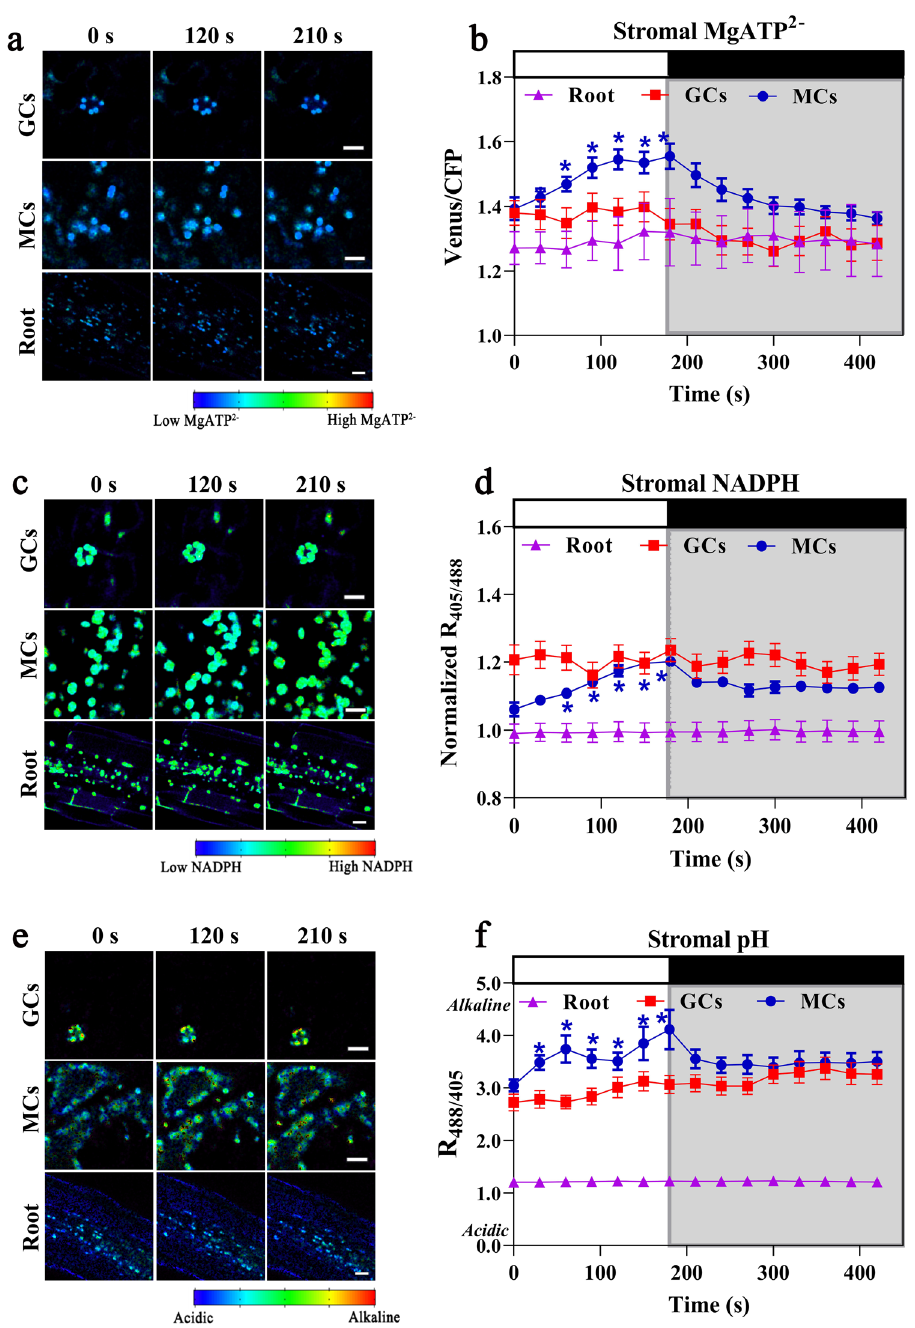
Fig. 2 Real-time light responses of stromal MgATP 2 – , NADPH and pH sensors in 21-day-old plants. The ratiometric shifts of a, b MgATP 2 – sensor AT1.03 ( p -values of panel b: 0 s vs. 60 s = 0.007, 0 s vs. 90 s = 0.001, 0 s vs. 120 s = 2.5 × 10 − 4 , 0 s vs. 150 s = 1.9 × 10 − 4 , and 0 s vs. 180 s = 4.3 × 10 − 4 ), c, d NADPH sensor iNAP4 ( p -values of panel d: 0 s vs. 60 s = 0.015, 0 s vs. 90 s = 0.001, 0 s vs. 120 s = 0.001, 0 s vs. 150 s = 0.001, and 0 s vs. 180 s = 0.006), e, f pH sensor cpYFP ( p -values of panel f: 0 s vs. 30 s = 0.012, 0 s vs. 60 s = 0.036, 0 s vs. 90 s = 0.021, 0 s vs. 120 s = 0.015, 0 s vs. 150 s = 0.041, and 0 s vs. 180 s = 0.032) in plastid stroma of mesophyll cells (MCs), guard cells (GCs) and roots in response to white light illumination at 216 μ mol m − 2 s − 1 (30-s intervals for 180 s) are presented. Asterisks indicate signi fi cant statistical differences (* P < 0.05) between the data points collected during illumination (30 – 180 s) and the data point collected before illumination (0 s), as determined by paired t -test, two-tailed ( n = 5; mean ± SEM). The white and black bars at the top indicate the light and dark period, respectively. Scale bars, 10 µ m. All iNAP results presented were normalized with stromal iNAPc. Ratio images are presented in pseudo-color, where red corresponds to high MgATP 2 – and NADPH levels and alkaline pH. Source data are provided as a source data fi